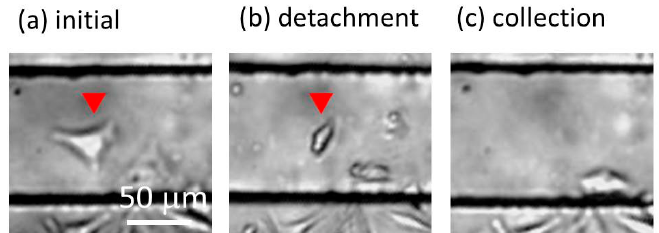
Figure 10. Detachment and collection of a high-migratory cell. ( a ) Initial condition. ( b ) The adhesive cell after the expansion of balloon for 20 min. It was detached. ( c ) Collection of the detached cell by flowing the cell culture medium at 500 μ L/min.